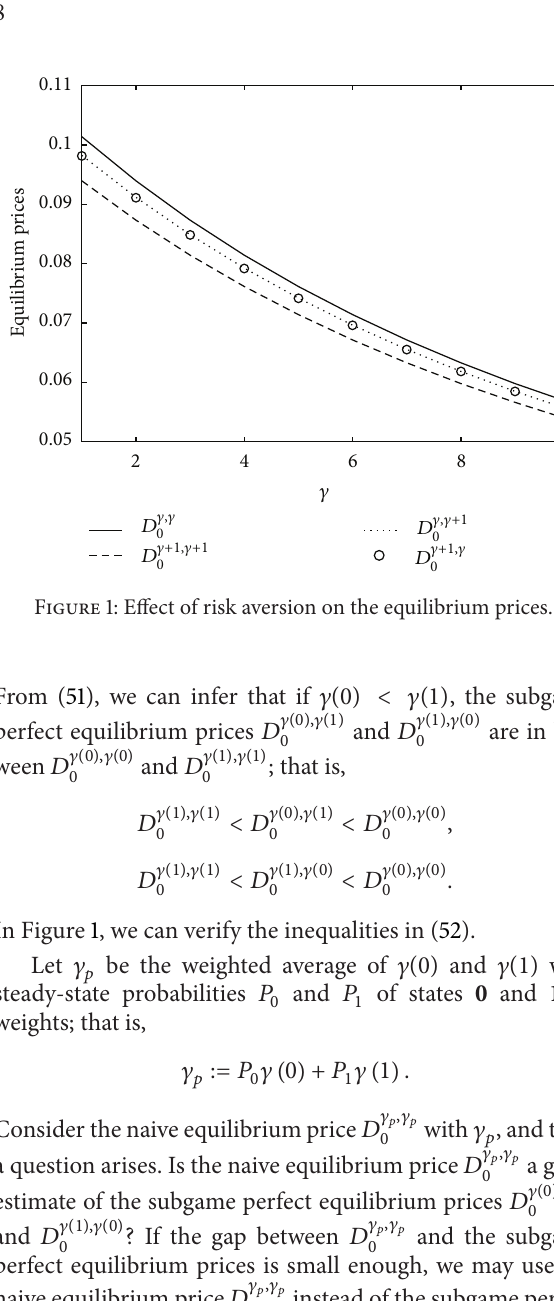
From (51), we can infer that if 𝛾(0) < 𝛾(1) , the subgame 𝛾(0),𝛾(1) 𝐷 𝛾(1),𝛾(0) perfect equilibrium prices 𝐷 0 and 0 are in bet- 𝛾(0),𝛾(0) 𝐷 𝛾(1),𝛾(1) ween 𝐷 0 and